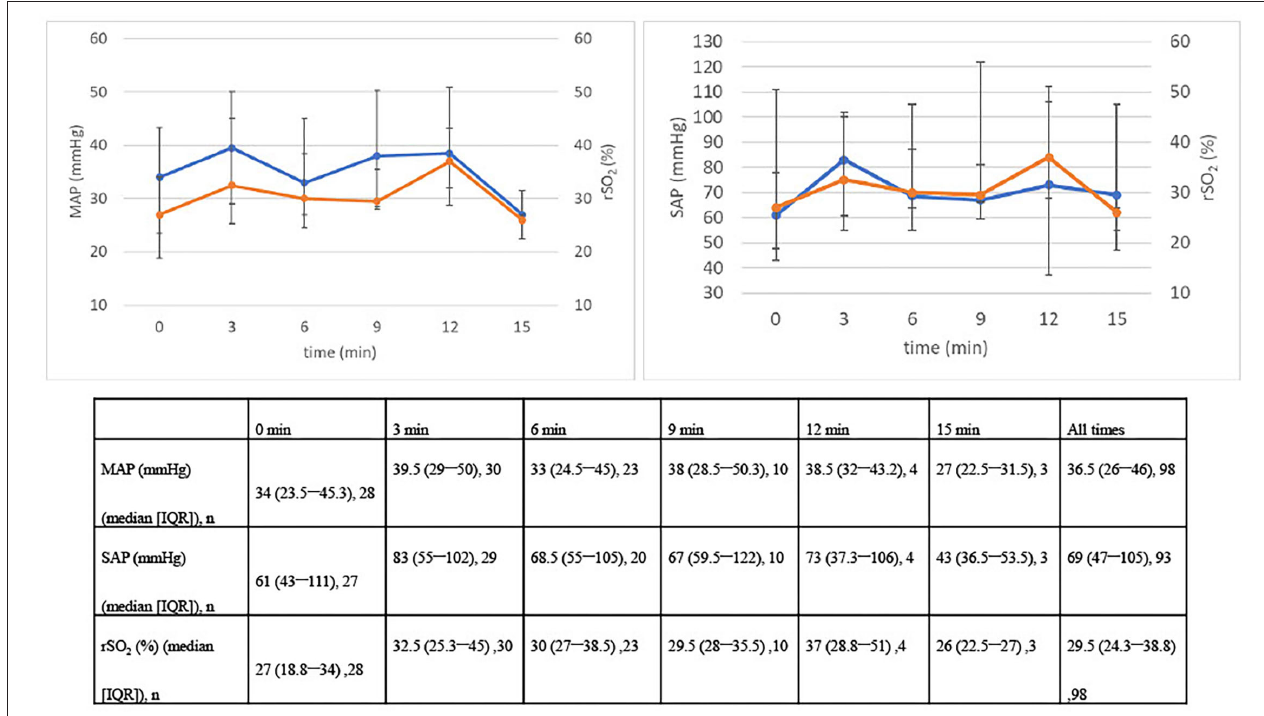
FIGURE 2 | Changes in MAP, SAP, and rSO 2 over 15min. IQR, interquartile range; MAP, mean arterial pressure; rSO 2 , regional saturation of oxygen; SAP, systolic arterial pressure.